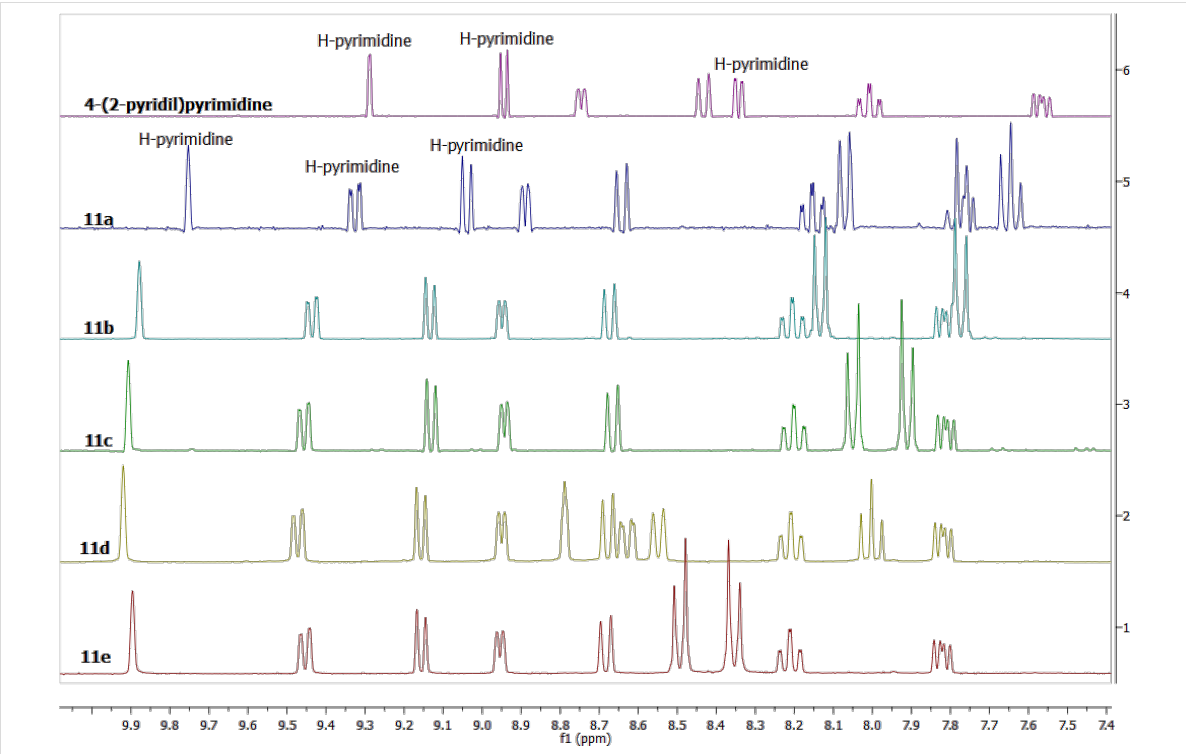
Figure 3: The 1 H NMR spectra (DMSO- d 6 ) of 4-(2-pyridyl)pyrimidine ( 6 ) and the corresponding bromides 11a–e (the aromatic region).